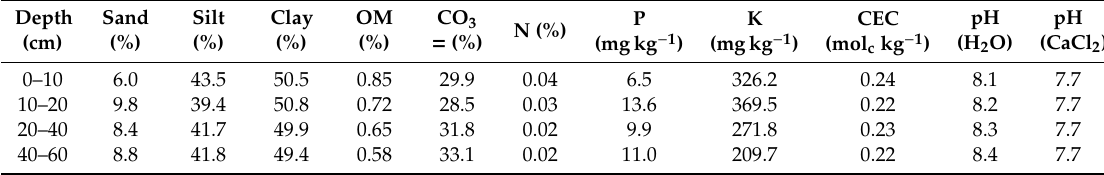
Table 1. Physicochemical characteristics of the